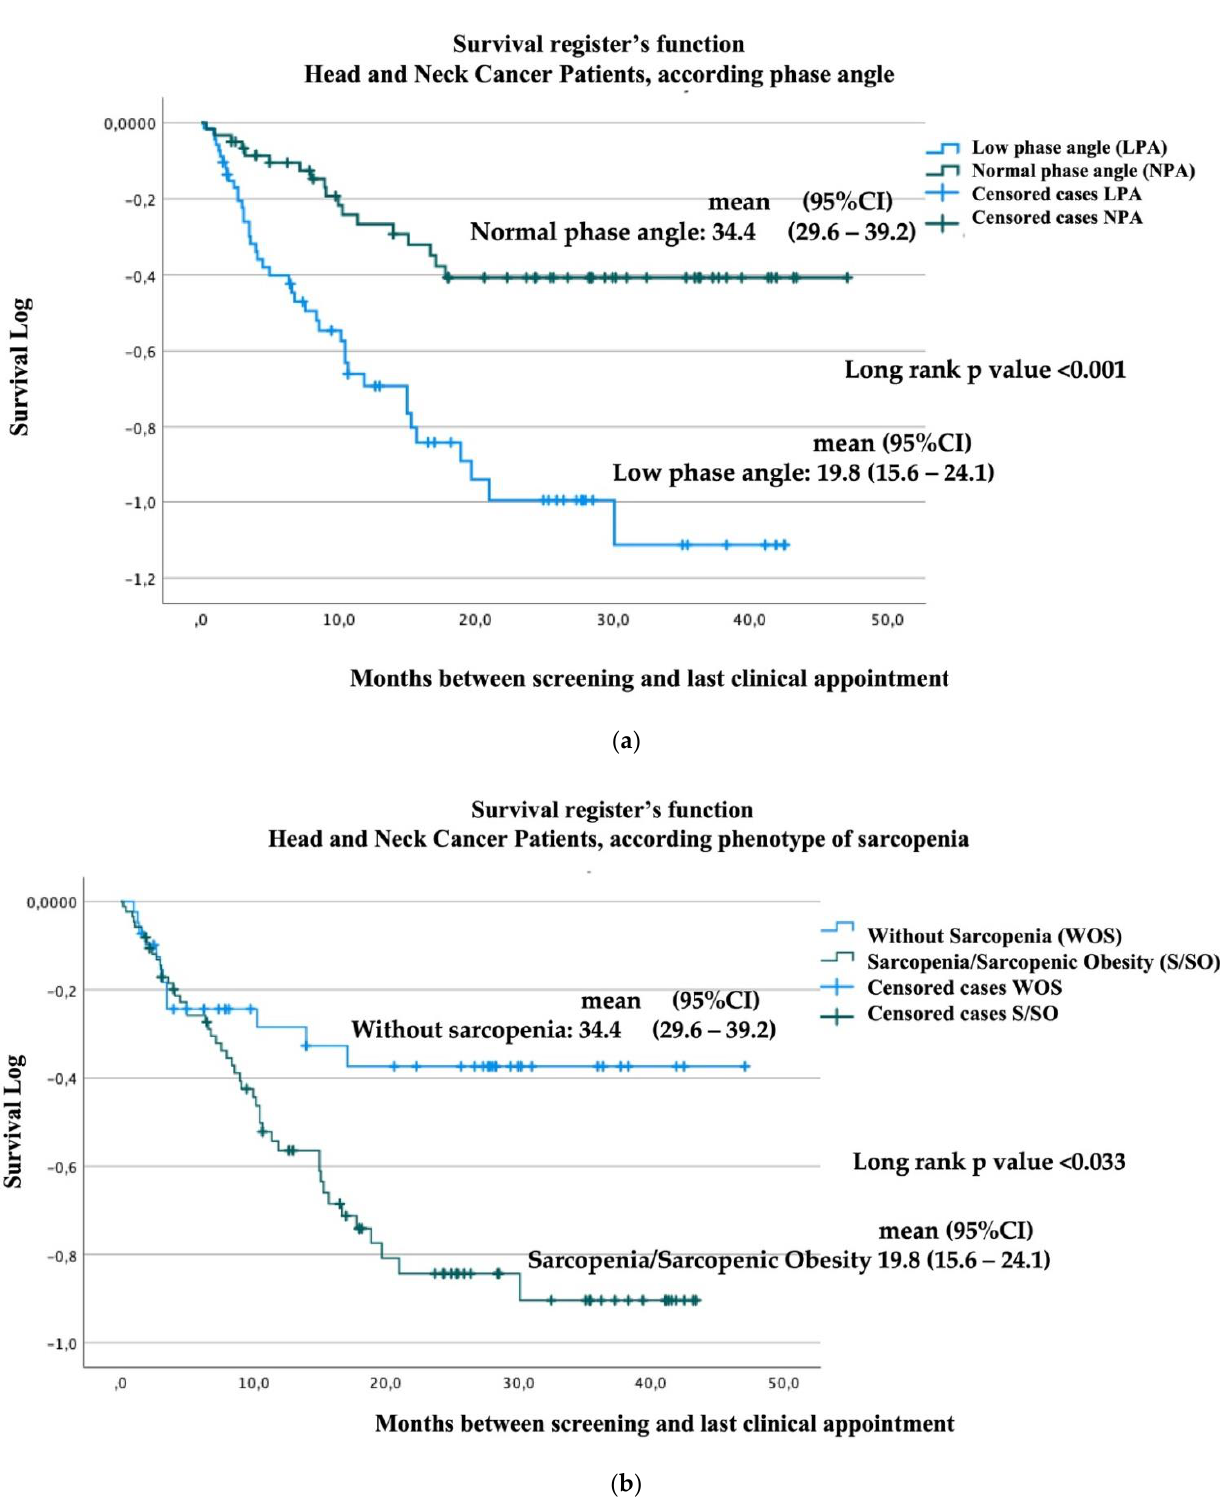
Figure 1. Kaplan – Meier survival analysis: ( a ) Log survival function by phase angle; ( b ) log survival function by sarcopenia phenotype.